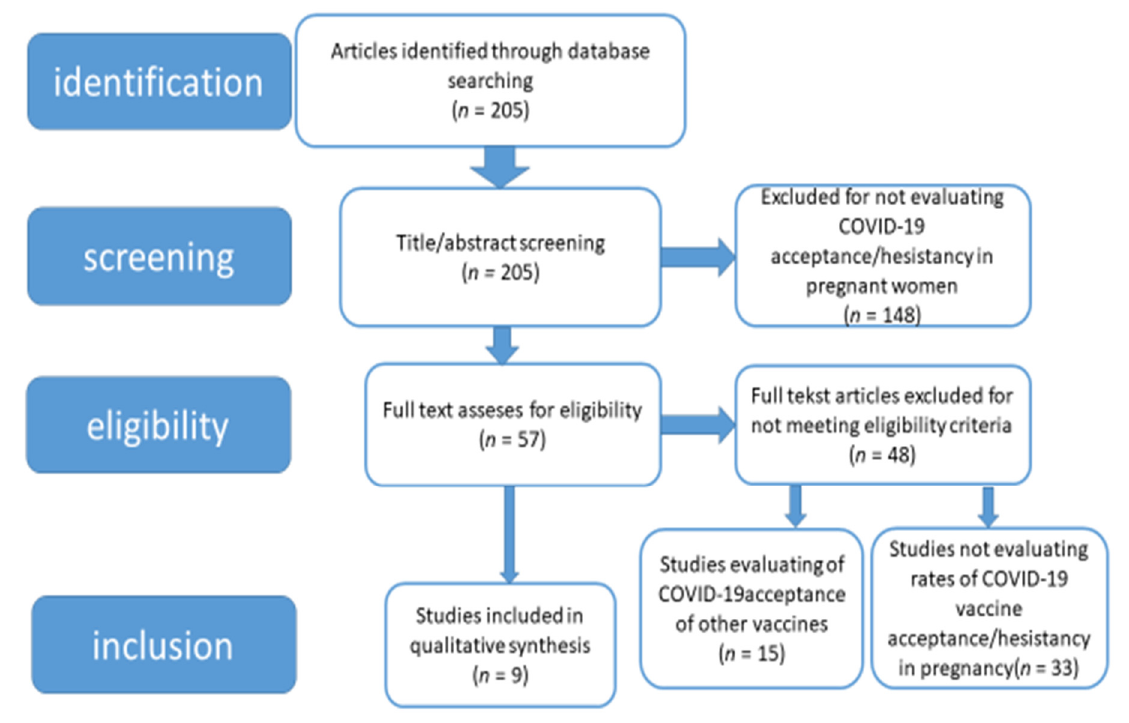
Figure 1. PRISMA flow chart of studies screened and included. Table 1. Characteristics of papers included in present